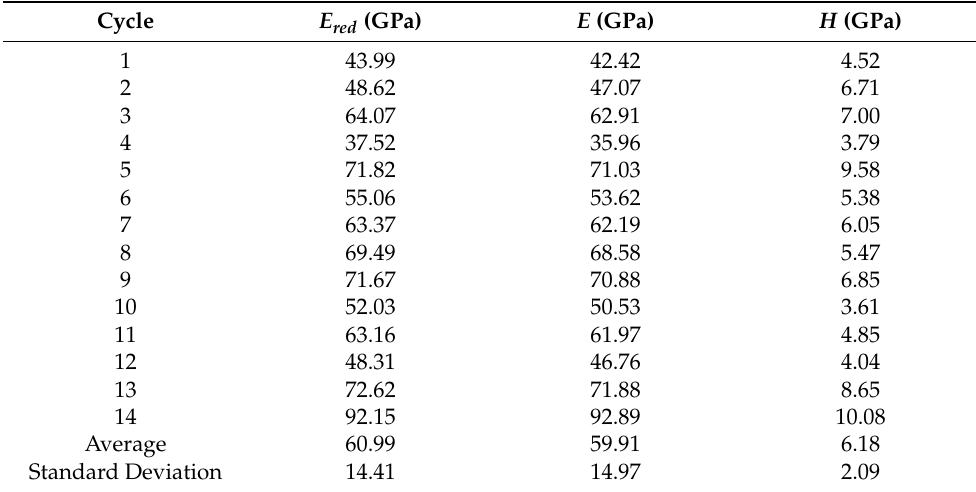
Table 4. Results of the nanoindentation tests; E red = Reduced modulus, E = Young ´ s modulus, H = hardness.